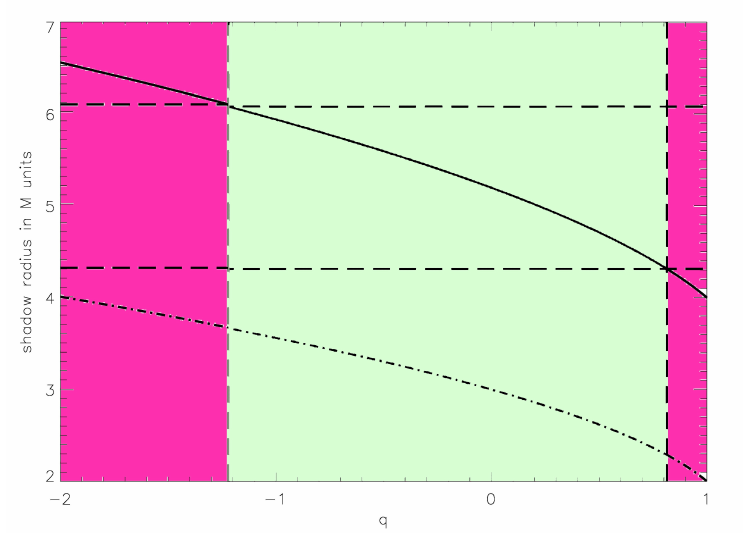
Figure 1. Shadow (mirage) radius (solid line) and radius of the last circular unstable photon orbit (dot- dashed line) in M units as a function of q . Similarly to [42] we adopt θ sh M87* ≈ 3 at 68% confidence levels as it was given in [52]. Horizontal dashed lines correspond to constraints on shadow radius in M units, namely, r low = 4.31 and r upper = 6.08. Light green vertical strip corresponds to q parameters which are currently consistent with the shadow size estimate done by the EHT collaboration [42] while rose strips correspond to q parameters which are not consistent with the shadow size